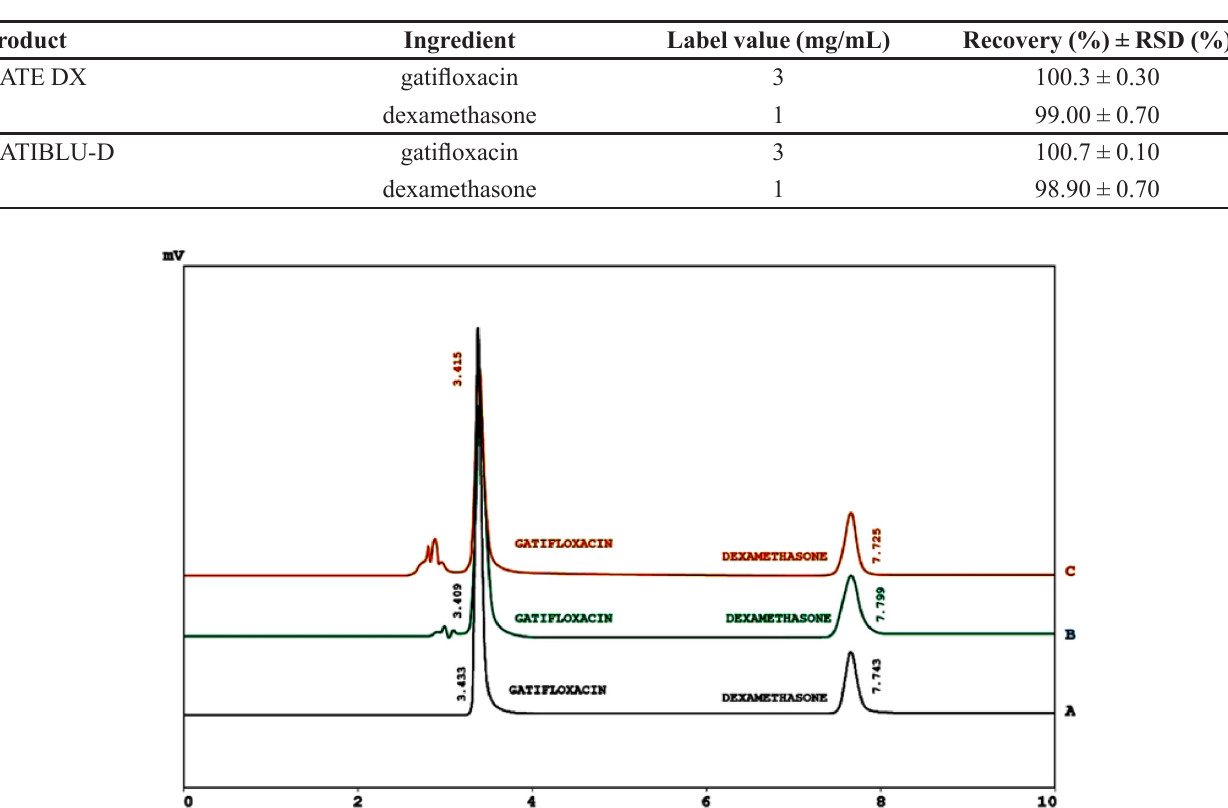
TABLE VI - Assay results of gatifloxacin and dexamethasone in commercial eye drops